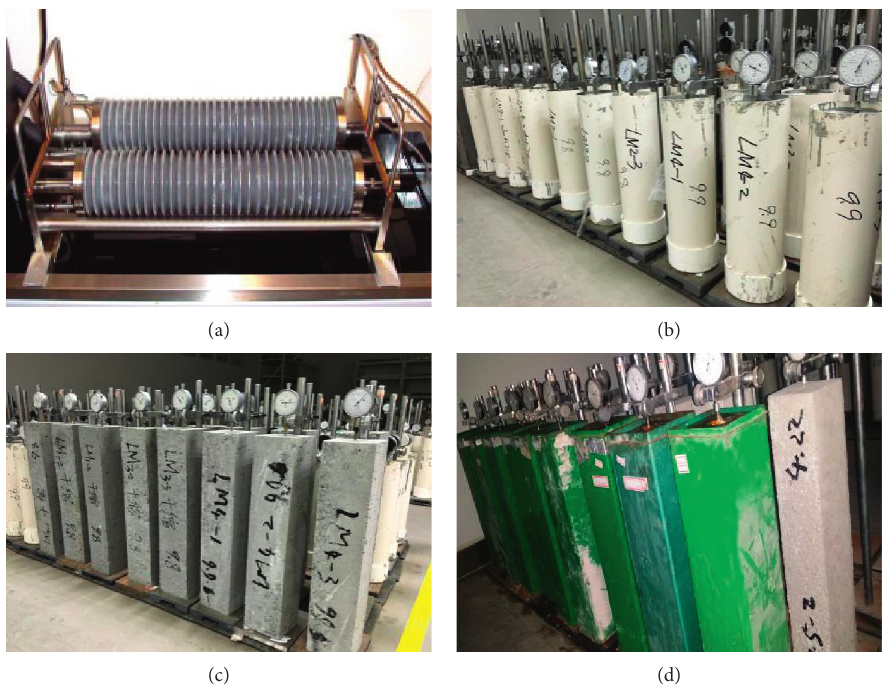
Figure 1: Concrete deformation performance tests. (a) Autogenous shrinkage test at the plastic stage. (b) Autogenous shrinkage test at the hardening stage. (c) Drying shrinkage test. (d) Restricted deformation test.